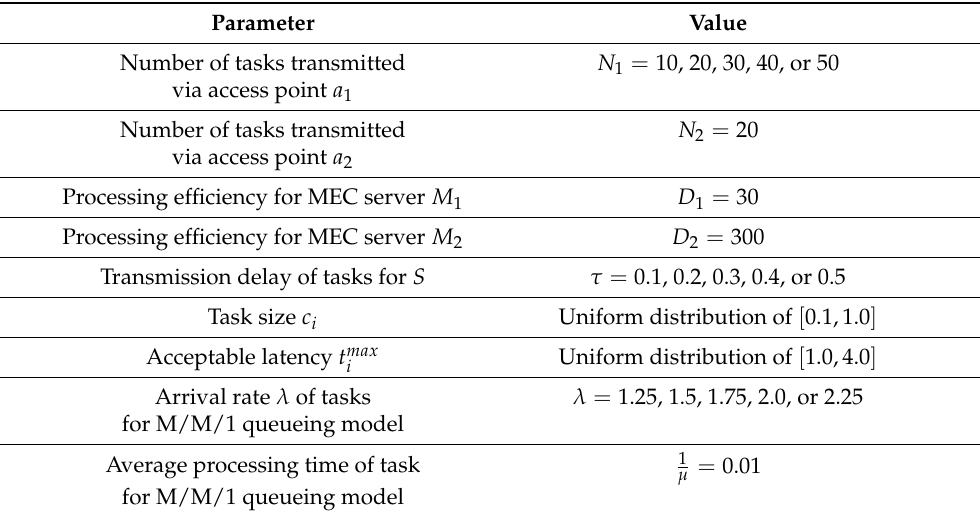
Table 1. Parameter settings in